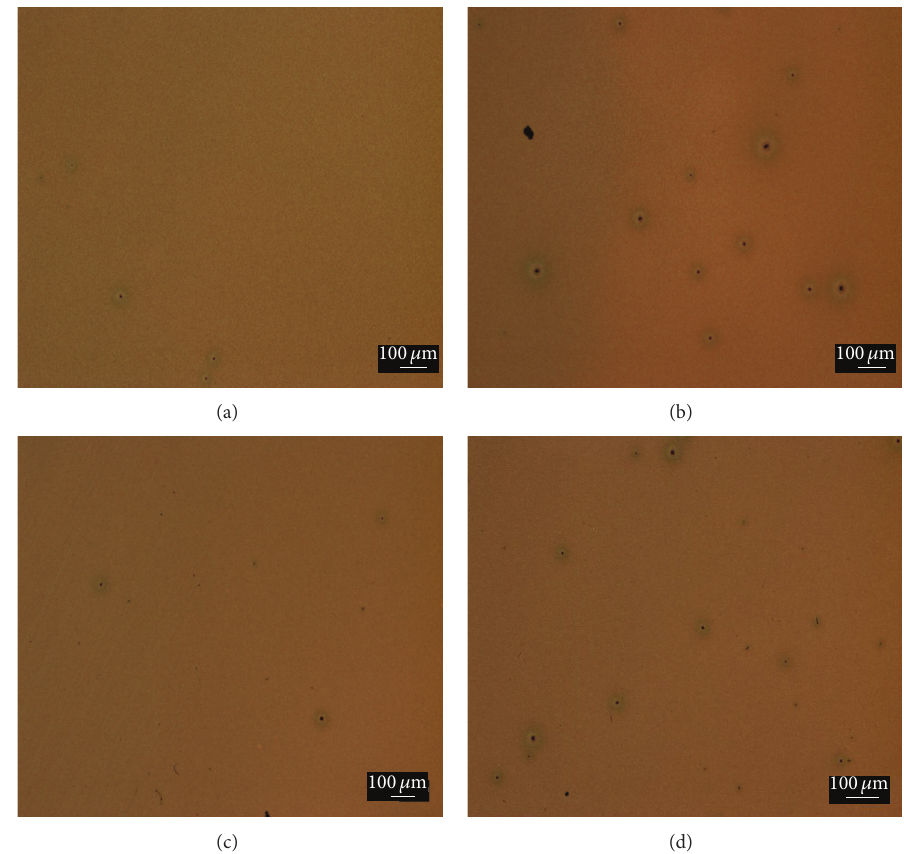
Figure 5: Optical microscope images; scale is 100 𝜇 m: (a) pristine P3HT layer unannealed, (b) pristine P3HT layer annealed, (c) P3HT layer with 30 vol% glycerol additive unannealed, and (d) P3HT layer with 30 vol% glycerol additive